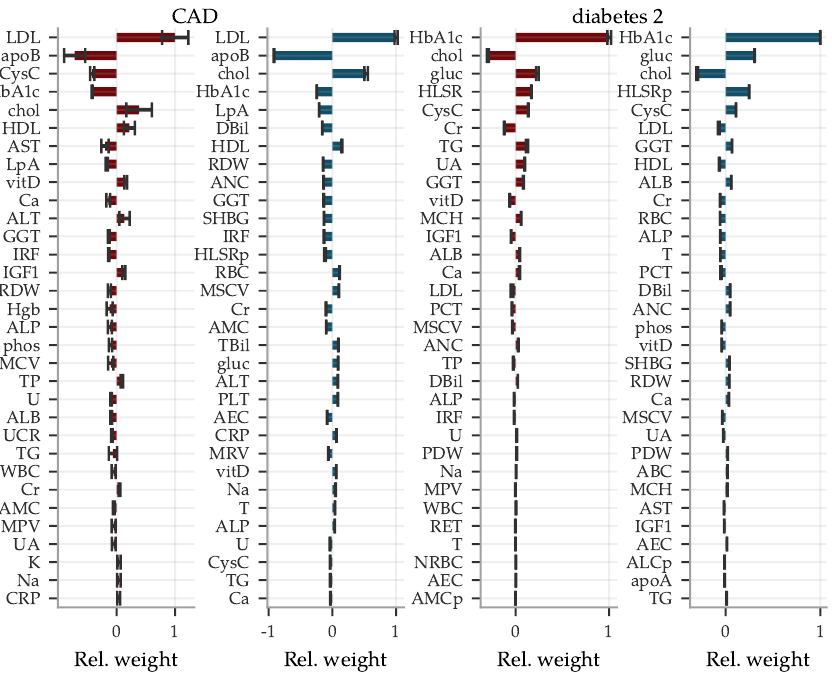
Figure 7. Predictors for phenotypes like CAD and type 2 diabetes from biomarkers are dominated by a top few inputs. Shown are relative weights (normalized with the largest magnitude) for the most important biomarkers within predictors for CAD and type 2 diabetes. women and men while error bars indicate ± standard deviations from the mean of five predictors. The most impactful biomarkers are very well-known but we highlight cystatin C as surprisingly frequent among the moderately strong coefficients. Corresponding plots for all condition predictors are shown in the Supplementary